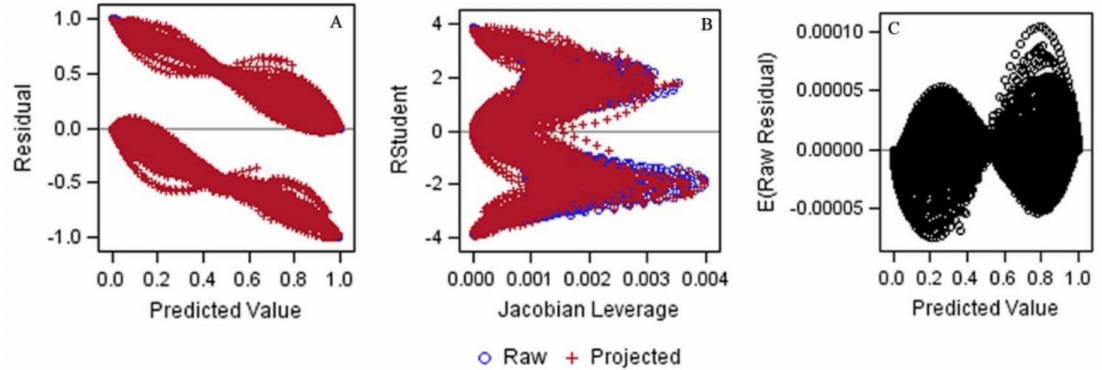
Figure 3. Diagnostic plots. ( A ) Residuals by predicted values; ( B ) Studentized residuals (RStudent) by Jacobian leverages; ( C ) Expected raw residuals by predicted